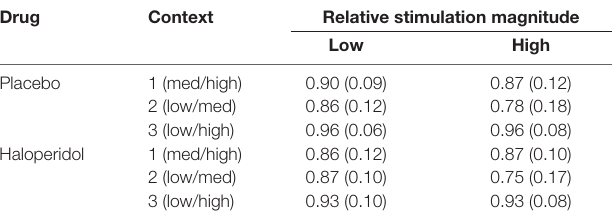
TABLE 5 | Proportion of hits in the adaptive task ( n = 20).